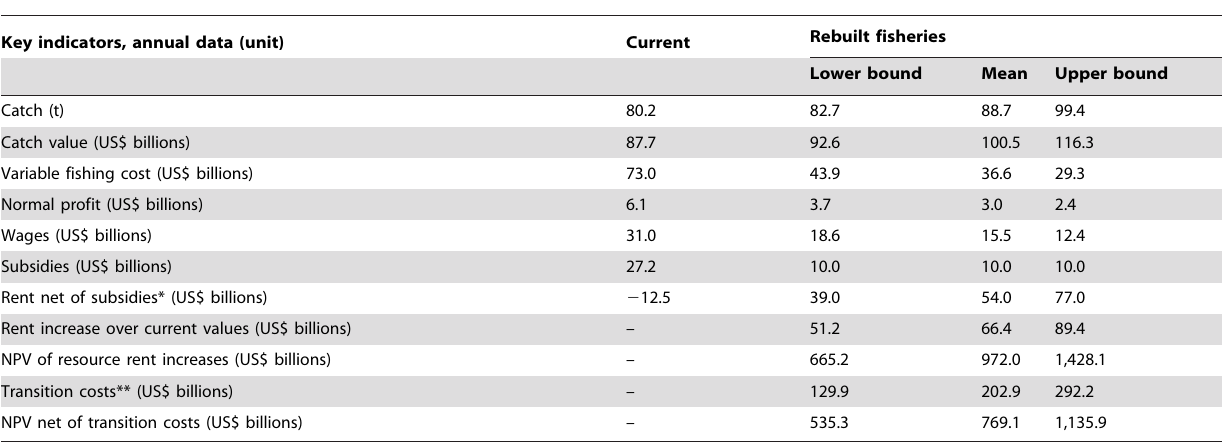
Table 1. Key economic figures of global fisheries.